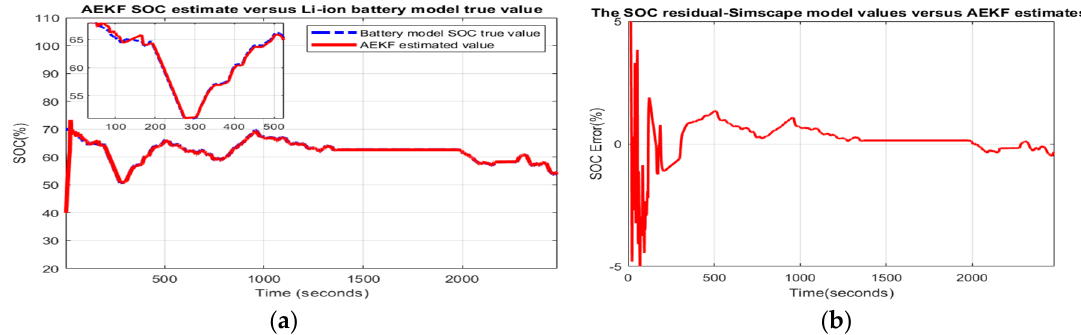
Figure A17. Robustness to simultaneous changes, SOCini = 0.4, σ noise = 0.01; ( a ) AEKF SOC value versus battery model true value; ( b ) SOC residual.